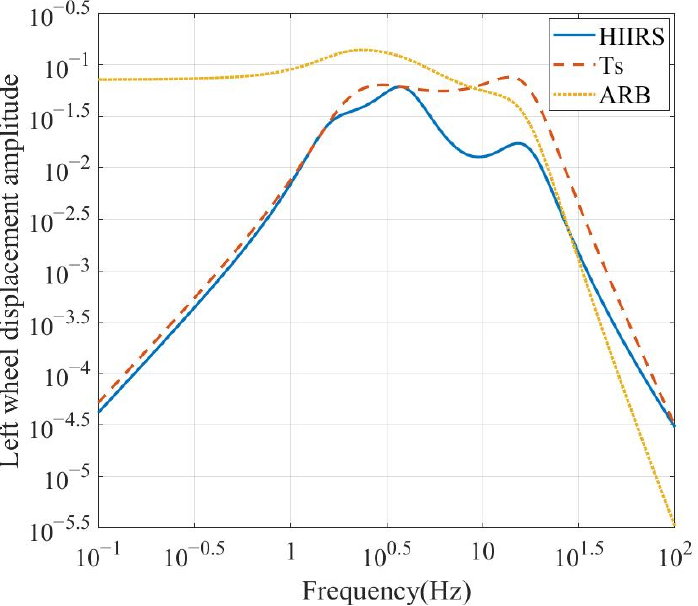
Figure 8. Amplitude frequency characteristics of left wheel displacement on right ground input.